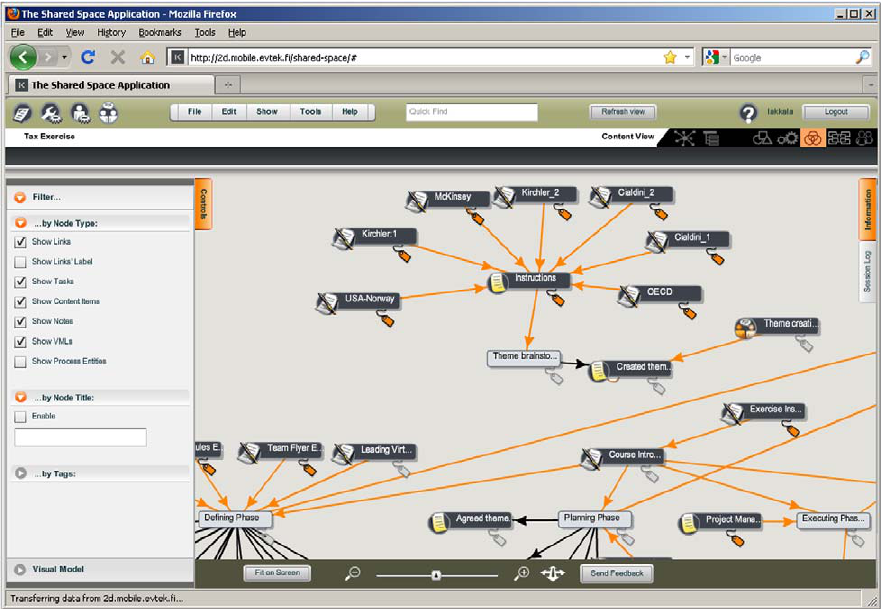
Figure 2. An example of the Content view in KPE. Note: The dark-shaded items are content items, such as up-loadable fi les, links to the Internet, and notes; the orange and black arrows are links added by the user; the light- shaded items are tasks de fi ned by the